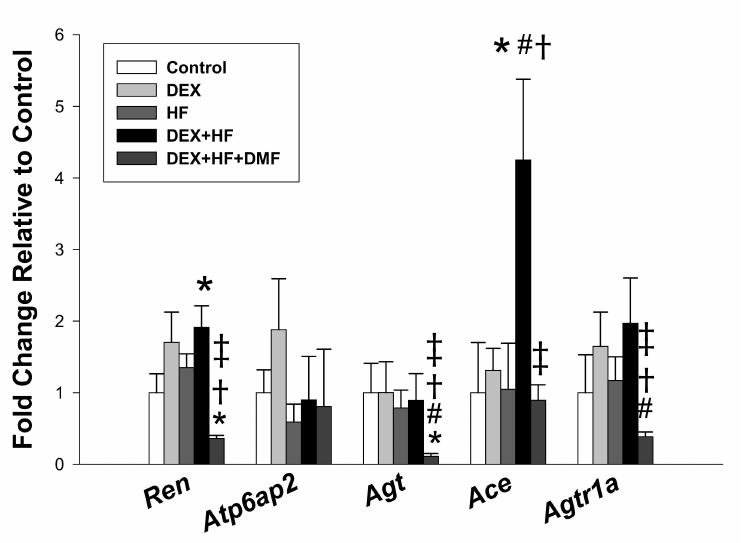
Figure 3. E ff ects of prenatal dexamethasone (DEX), postnatal high-fat diet (HF), and dimethyl fumarate (DMF) on mRNA expression of the renin-angiotensin system in male o ff spring kidneys at 16 weeks of age. * p < 0.05 vs. control; # p < 0.05 vs. DEX; † p < 0.05 vs. HF; ‡ p < 0.05 DEX + HF. n = 8 /